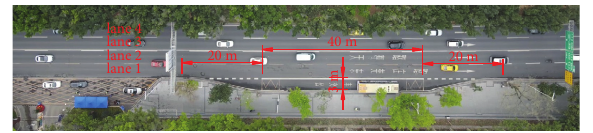
Figure 1: Sample stop of bus bay